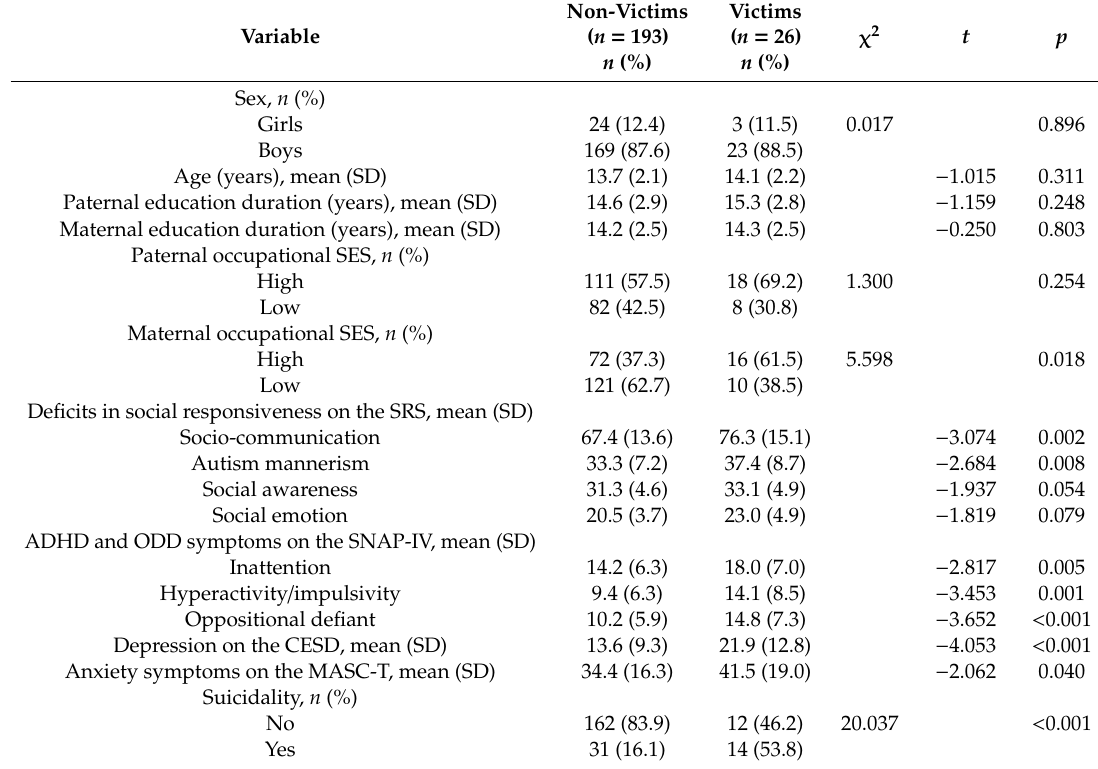
Table 1. Comparisons of sociodemographic characteristics, deficits in social responsiveness, ADHD and ODD symptoms, depression, anxiety, and suicidality between victims and non-victims of teacher harassment (N = 219).